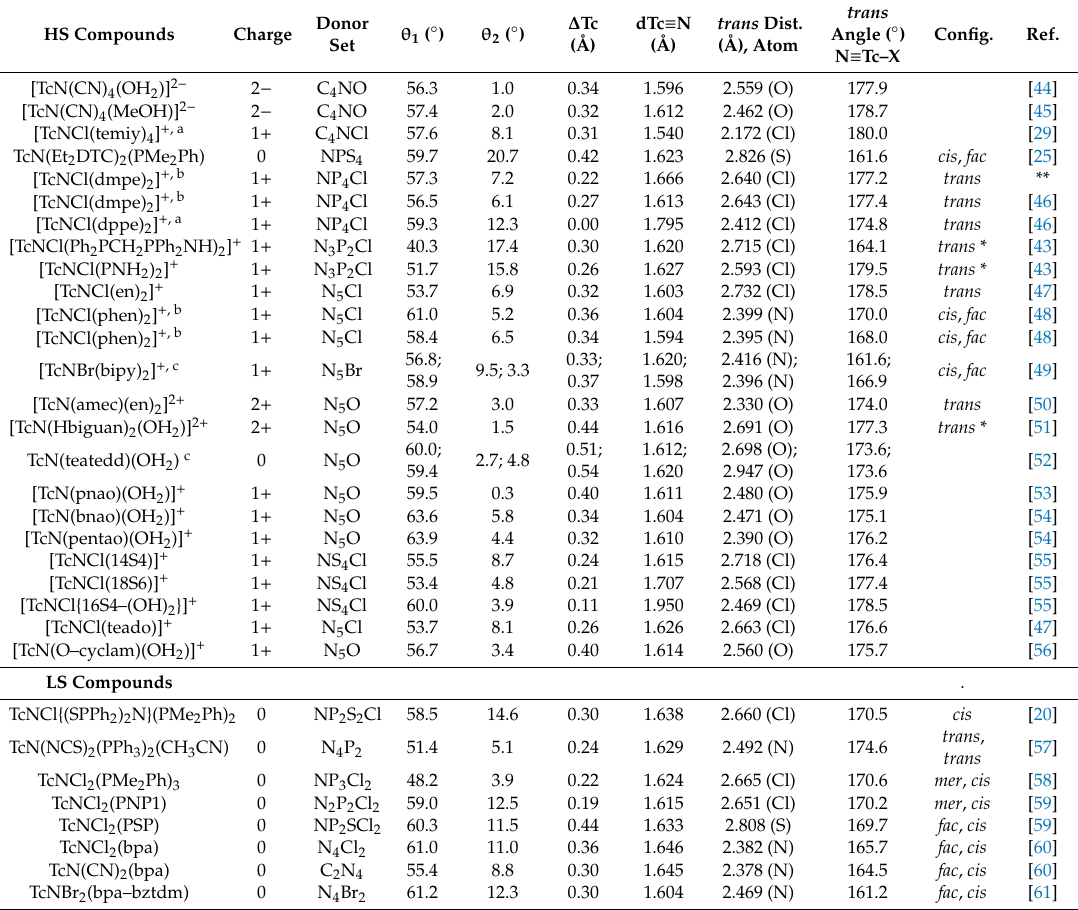
Table 2. Structural parameters of higher symmetry (HS) and lower symmetry (LS) six-coordinated Tc(V) nitride